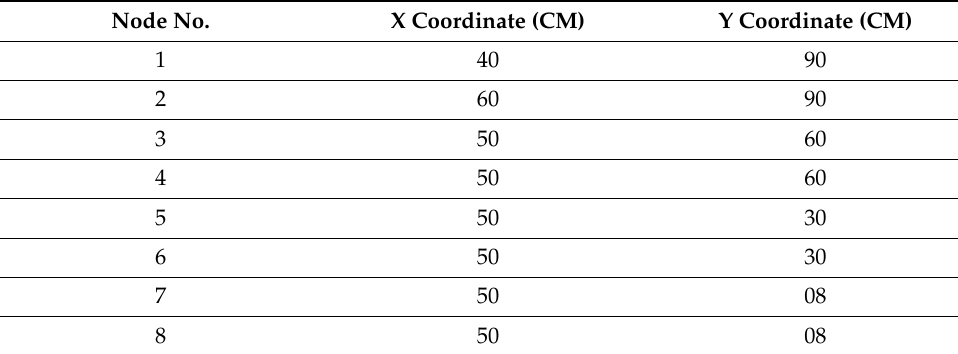
Table 5. The position of the nodes on the body [112]. Node No. X Coordinate (CM) Y Coordinate